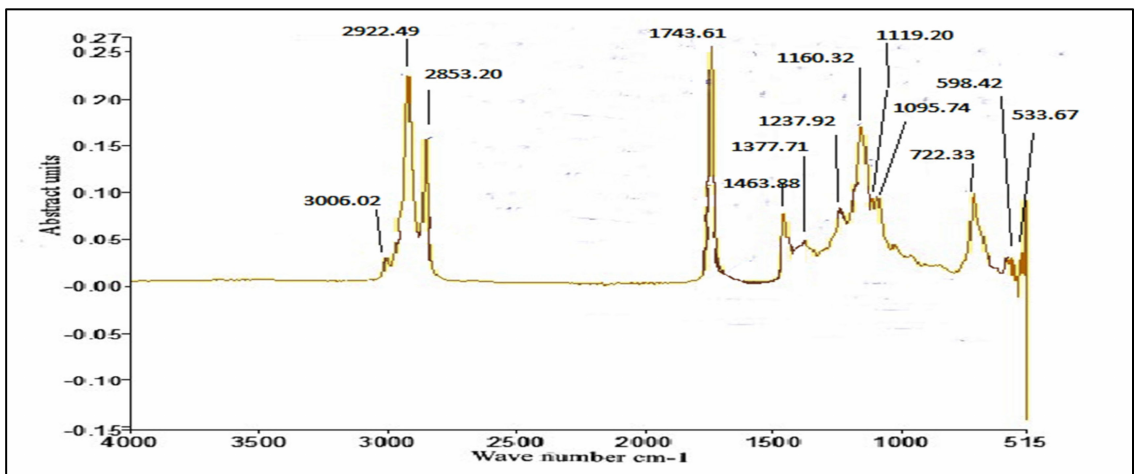
Figure 16. FT-IR analysis Prunus aitchisonii by using